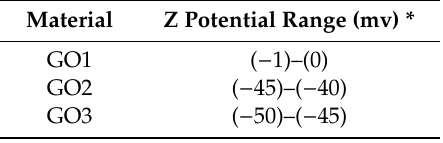
Figure 9. Anti-adhesion performance of membranes against E. coli . Table 6. Zeta potential of GOs used to modify